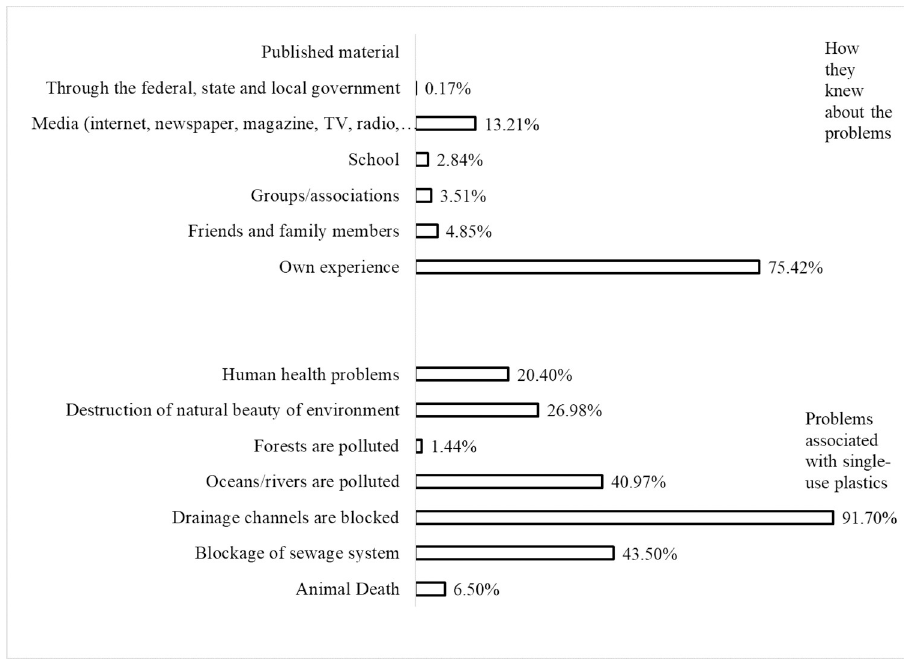
Fig 3. Opinion of the respondents regarding environmental problems associated with single-use plastics and how they knew about it. Given multiple responses, the result shows that most respondents (91.70 percent) indicated that blocking drainage channels was the environmental problem associated with single-use plastics. Also, a high proportion of them believed that blockage of sewage systems (43.50 percent) and pollution of ocean and rivers (40.97 percent) were the problems associated with single-use plastics. Only 1.44 percent of them indicated that forest pollution was one of the problems associated with single-use plastics. This finding suggests that Lagos residents consider blockage of drainage channels, blockage of sewage systems and pollution of oceans and rivers as the main problems associated with single-use